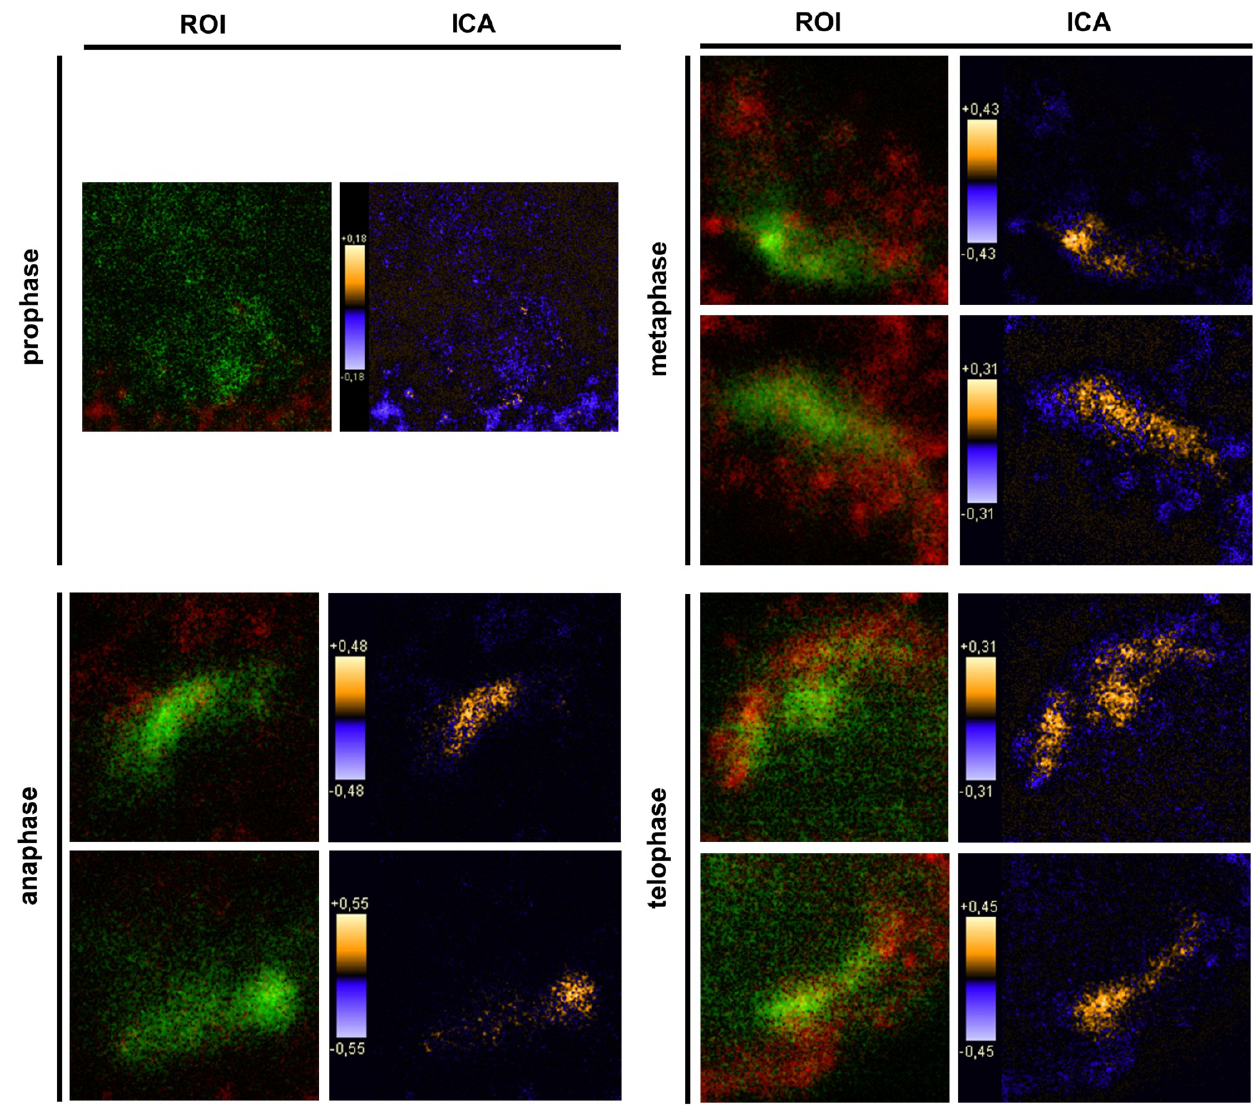
Figure 6. Intensity correlation analysis (ICA) of PTPIP51 and tubulin in mitotic cells. Region of interest (ROI) was set to the tubulin staining of each cell of Figure 5B. The co-localization of PTPIP51 and tubulin is displayed in orange. Sites of non-co-localization are marked in